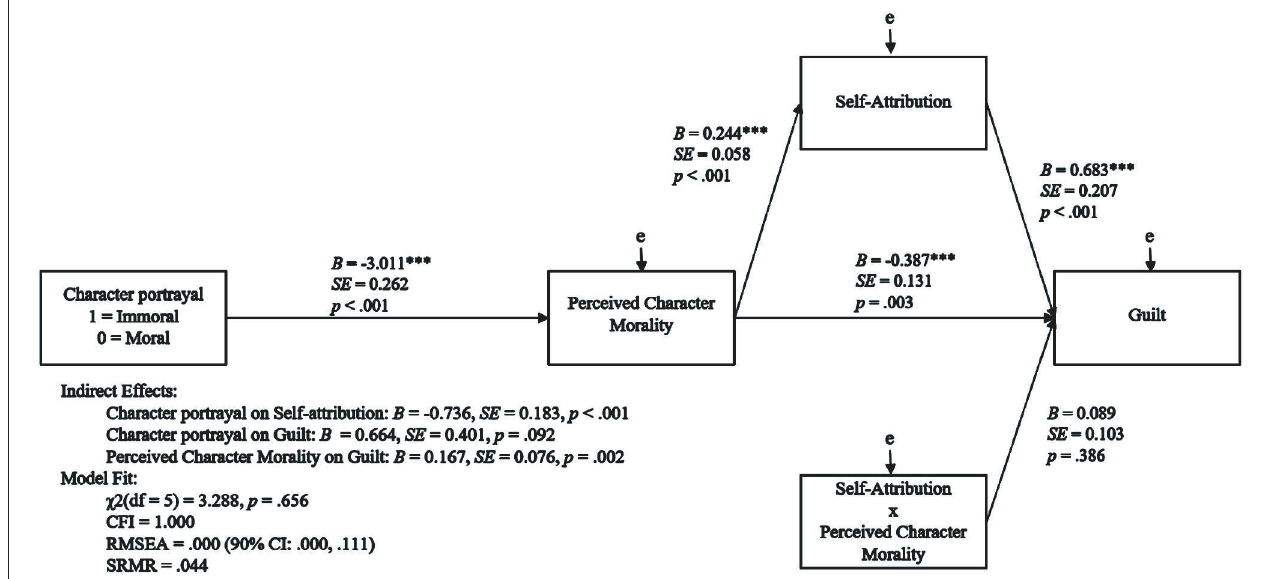
FIGURE 1 | Path model examining the hypotheses of the current study (*** p <